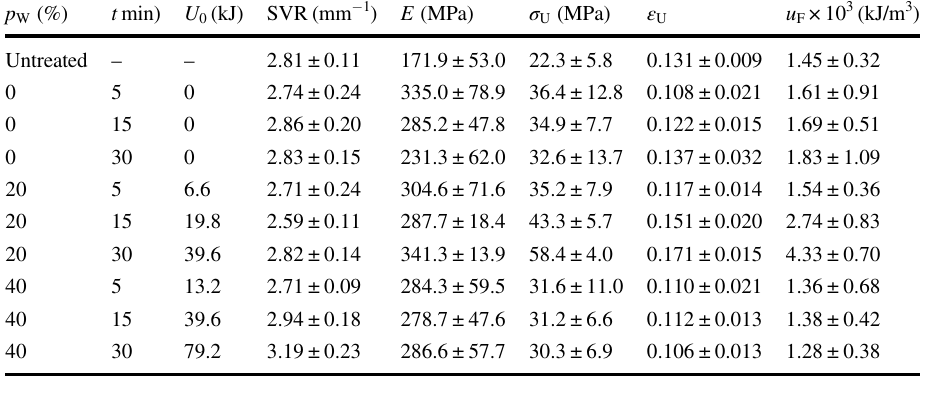
Fig. 7 Main effects plots of the mechanical properties of PLGA/ PVA scaffold with respect to sonication power ( p W ), and soaking duration ( t ). A , B Stiffness, E . C , D Fracture strength, σ U . E , F Strain at fracture, ε U . G , H Fracture toughness, u F . Note that the value of the respective bars on each graph represented the average (plus – minus standard deviation of sample) of all the levels at each p W or at each t